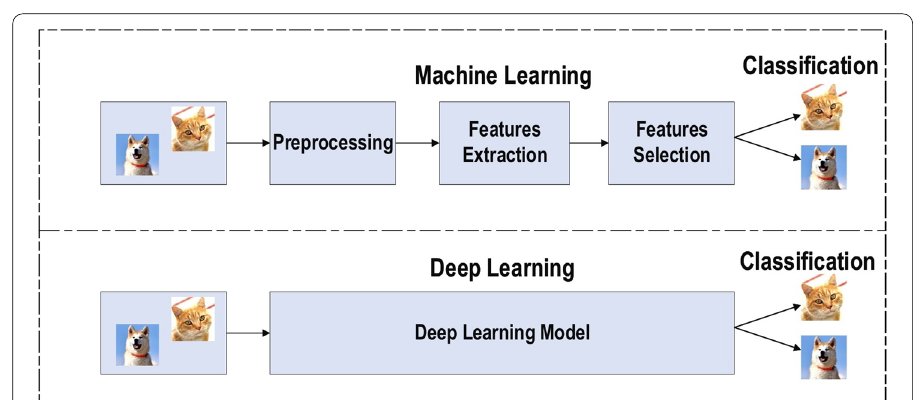
Fig. 2 Deep learning family